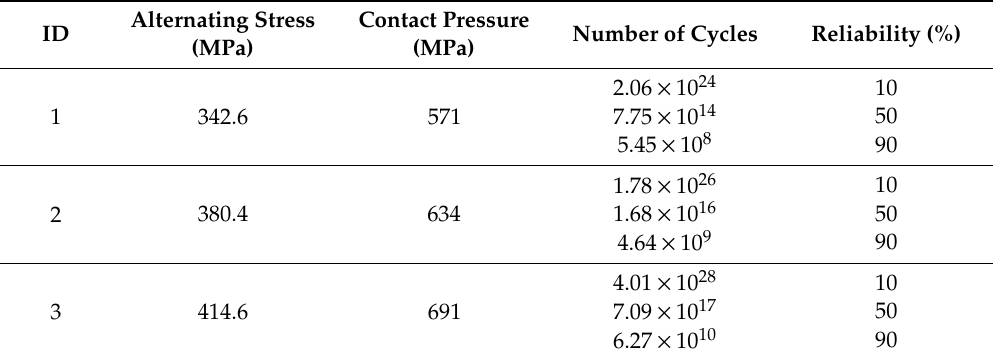
Table 5. The estimated allowable number of cycles for the considered curvature radii pairs and reliability